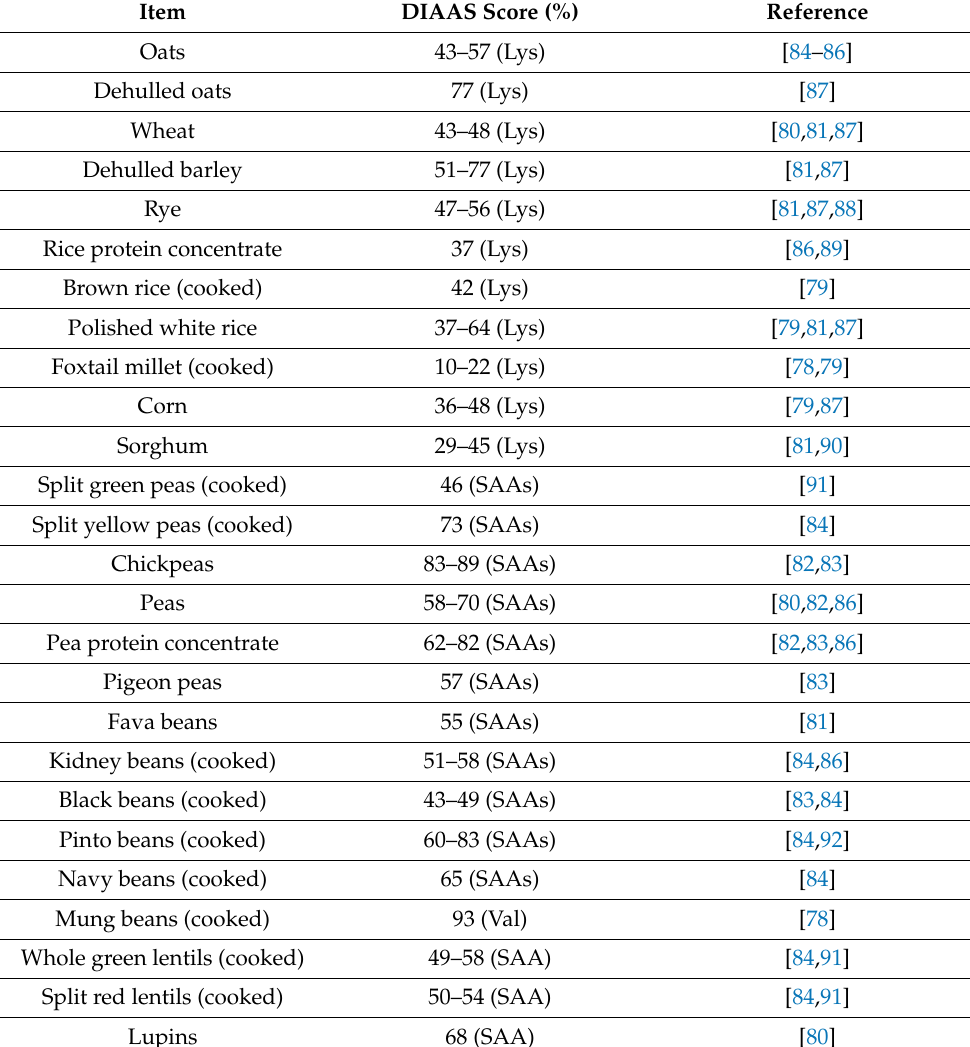
Table 3. The digestible indispensable amino acid score for cereal grains and pulses. The DIAAS score is determined by the lowest digestible indispensable amino acid value in the protein mixture. SAAs: sulfur amino acids (Met +